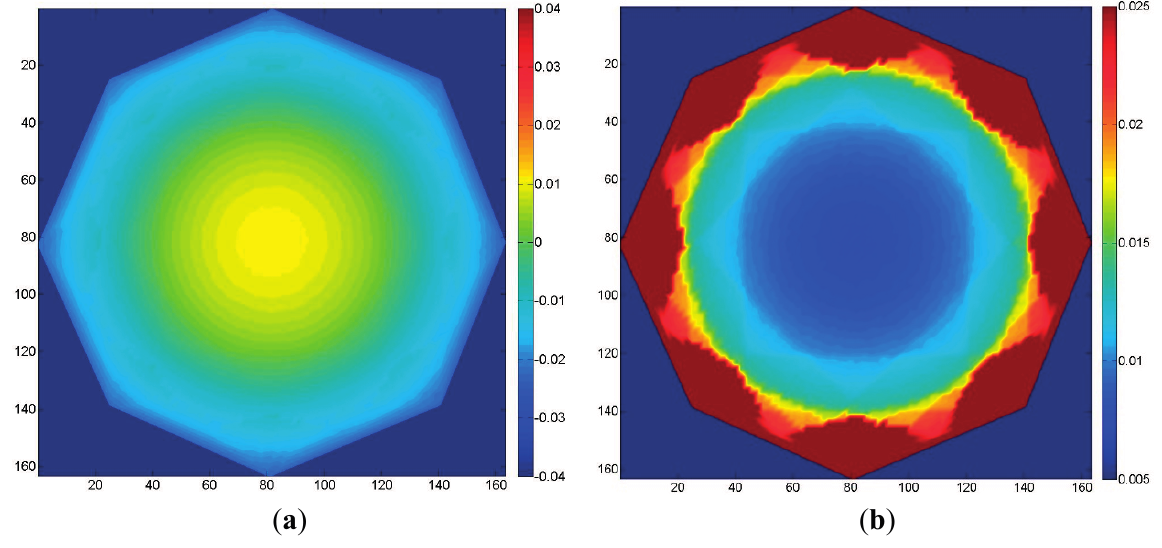
Figure 8. Case 2-B: eight convergent images; errors with camera the principal distances (PDs) estimated in the bundle block adjustment (BBA) (self-calibration). ( a ) Mean error; ( b ) standard deviation of the